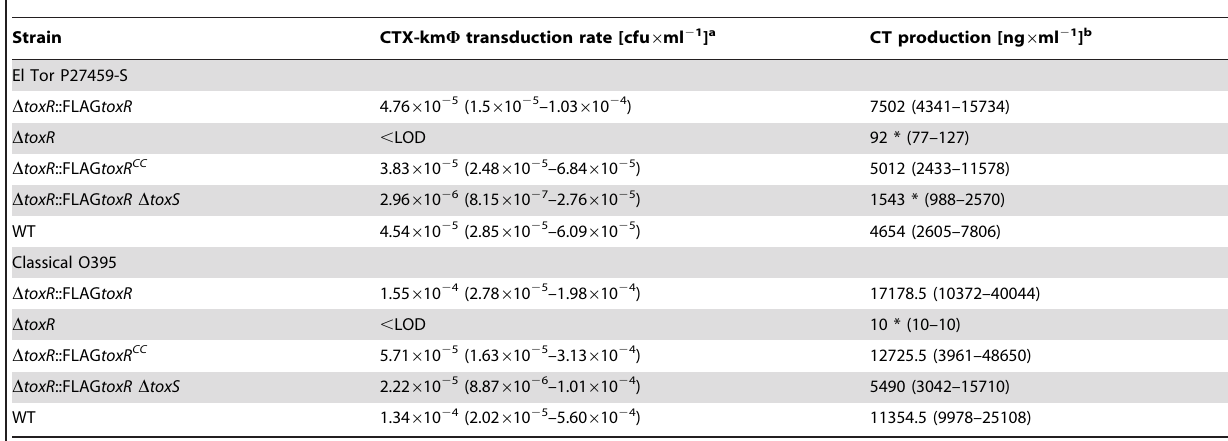
Table 3. Virulence factor production of chromosomal encoded FLAG-tagged toxR and FLAG-tagged toxR CC mutants.